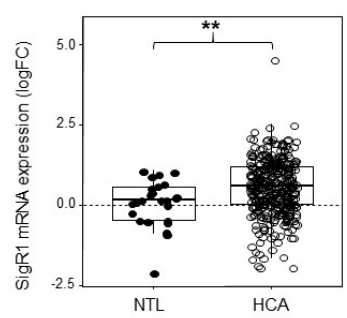
Figure 1. Level of expression of SigR1 in hepatocellular adenoma (HCA). Box-and-whisker plot of mRNA expression of SigR1 in non-tumoral liver (NTL, solid dots, n = 35) and HCA (empty dots, n = 349). P = 8.4 × 10 − 9 . Data are shown as mean ± SEM, Mann–Whitney U test. ** p < 0.01.